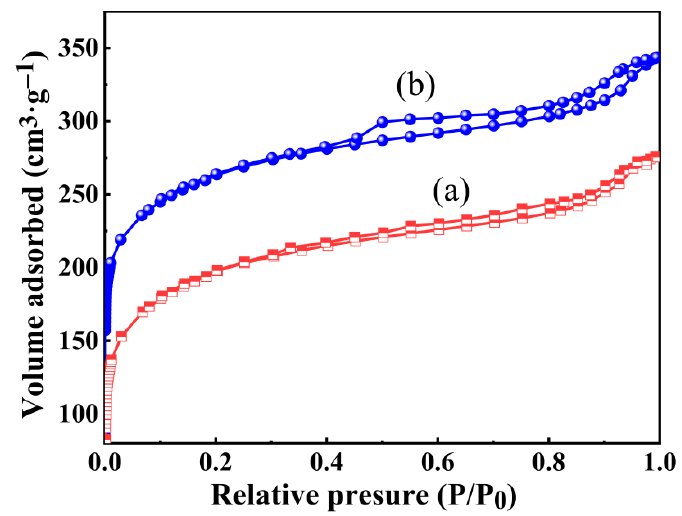
Figure 6. The N 2 adsorption-desorption isotherms for the ( a ) hydrophilic and ( b ) hydrophobic ZrO 2 -SiO 2 xerogels.